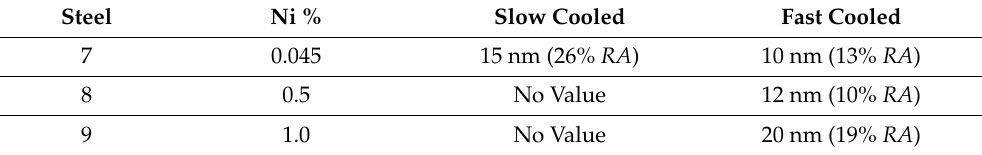
Table 3. Average particle size, nm of Ti(C,N) precipitates at 900 ◦ C [30]. Steel Ni % Slow